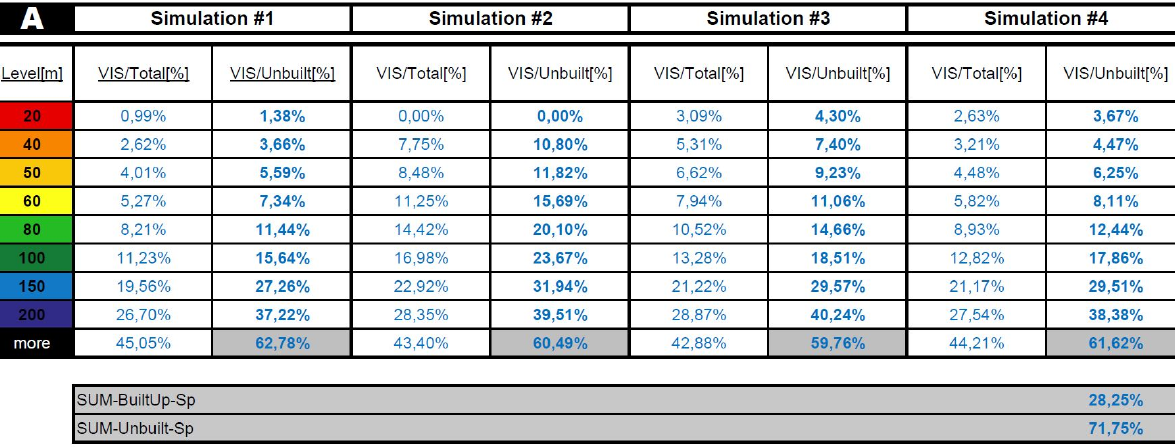
Table 1. Summary of results of VIS simulations for the area